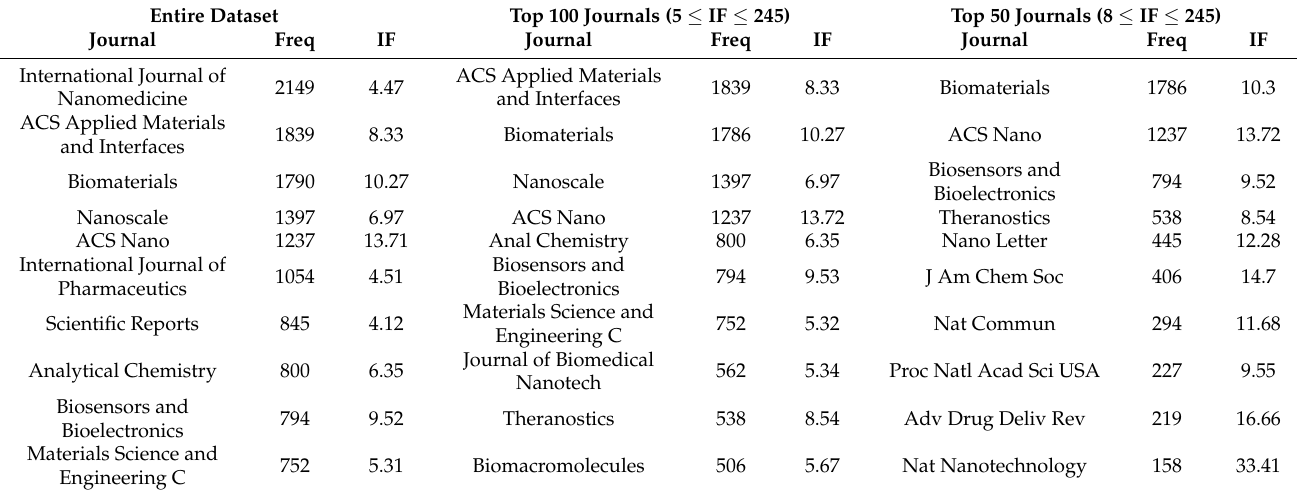
Table 3. Top 10 journals published in the area of cancer nanotechnology for the three scenarios with their impact factors. Entire